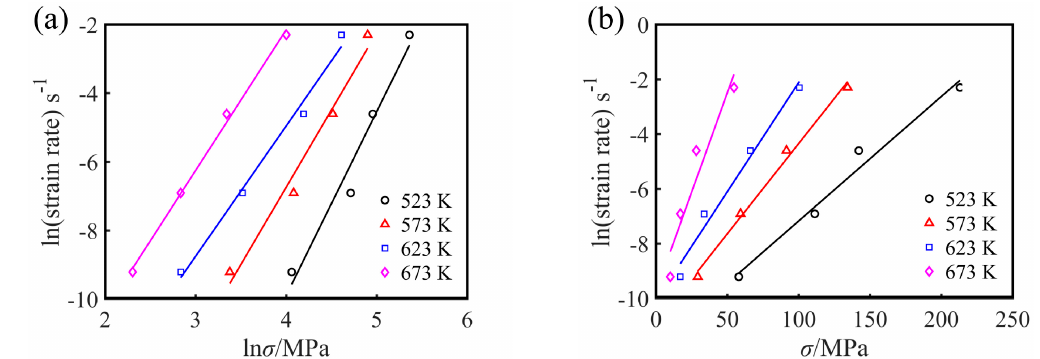
Table 1. The Q , α , and n values of various extruded AZ Mg alloys.